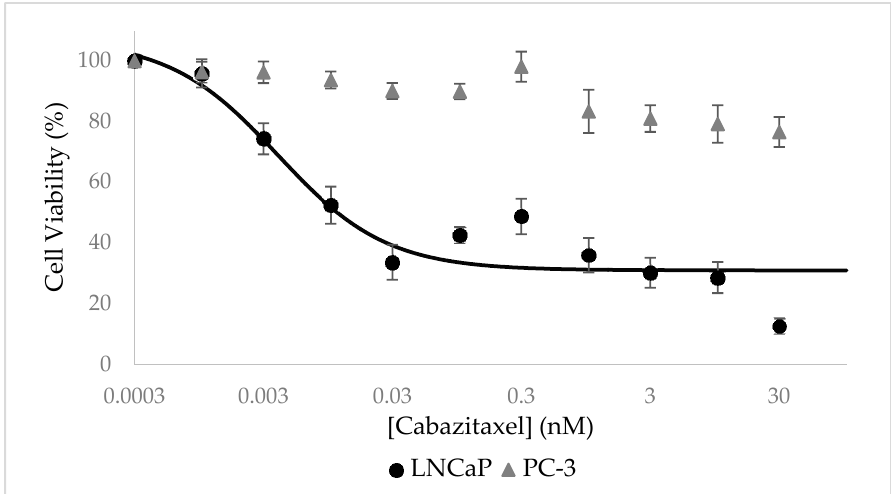
Figure 12. Selective growth inhibition of LNCaP target cells by CTX-loaded NPs. Cell growth inhibition as a function of the concentration of CTX encapsulated within NPs (0.6:1 CTX:SA-PEG molar ratio) in LNCaP target cells (circles) and non-target PC-3 cells (triangle). Values presented are means ± SE, n = 3 (three independent experiments, each performed in triplicates). The sigmoidal model curve of LNCaP cells was fitted using Equation (3).